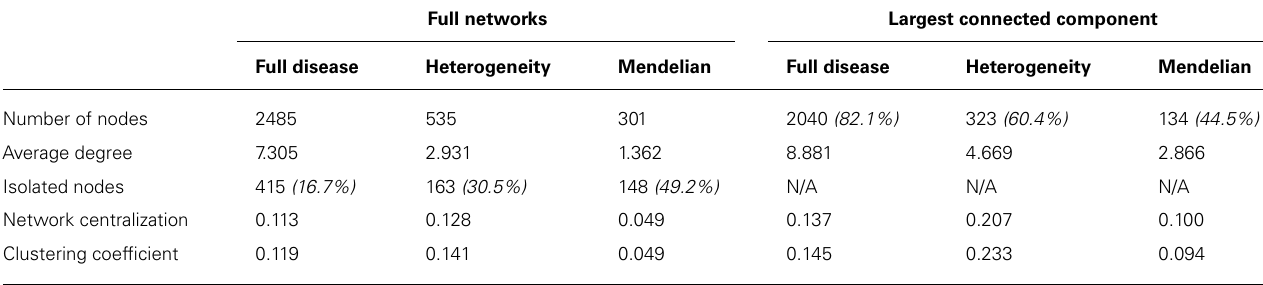
Table 1 | Disease network parameters.